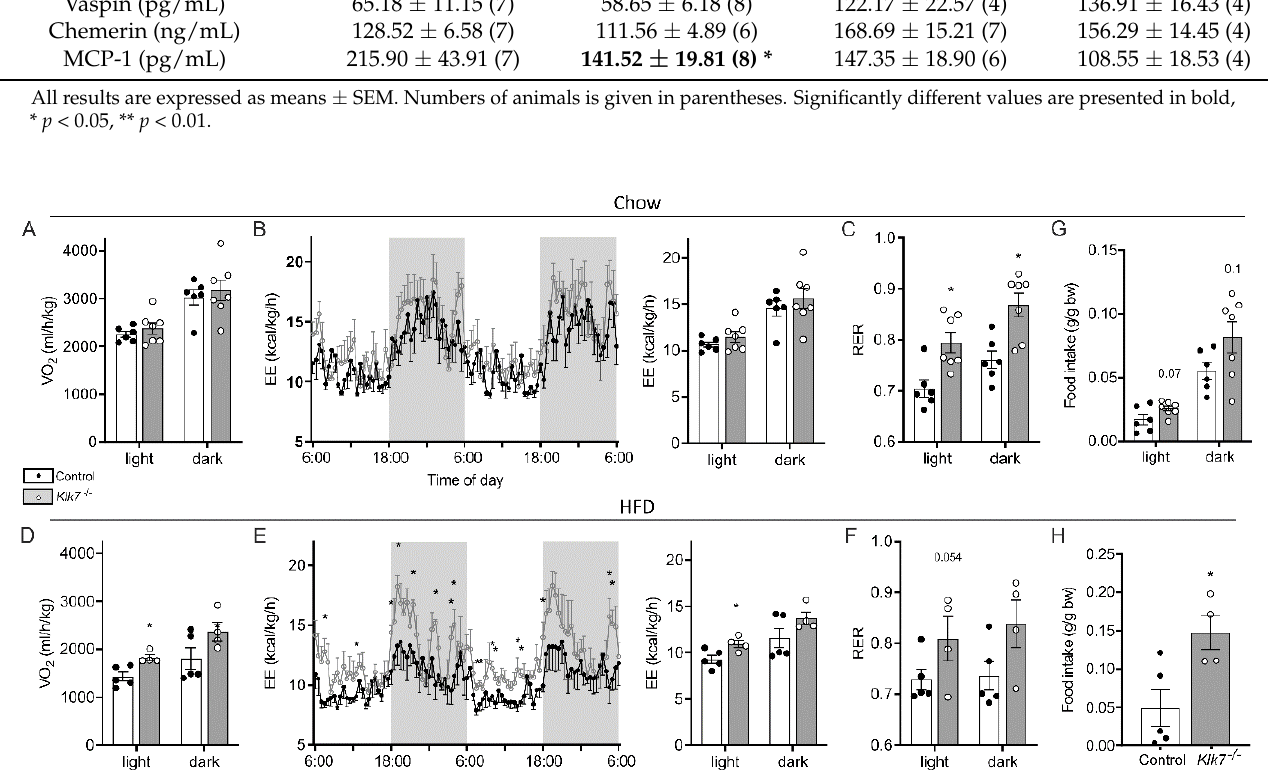
Figure 2. Indirect calorimetry of Klk7 − / − mice under chow and high fat diet. ( A , D ) Oxygen consumption (VO 2 in mL/kg/h, means during light and dark phase), ( B , E ) energy expenditure (EE in kcal/kg/h; left panel: time course over 48 h; right panel: means during light and dark phase) and ( C , F ) respiratory exchange ratio (RER, as means during light and dark phase) were recorded for a period of 60 h in control and Klk7 − / − mice fed chow diet ( A – C ) or HFD ( D – F ). ( G ) Food intake (g/g body weight) during light and dark phase over a period of 60 h in mice fed a chow diet. ( H ) Food intake (g/g body weight) per day over a period of 60 h in HFD-fed mice. Data are presented as means ± SEM; significance was tested by two-way ANOVA and Fisher’s LSD test ( B , E ) or multiple t -tests without correction for multiple testing (summarized data in A – F ) or Student’s t -test ( G – H ).* p <